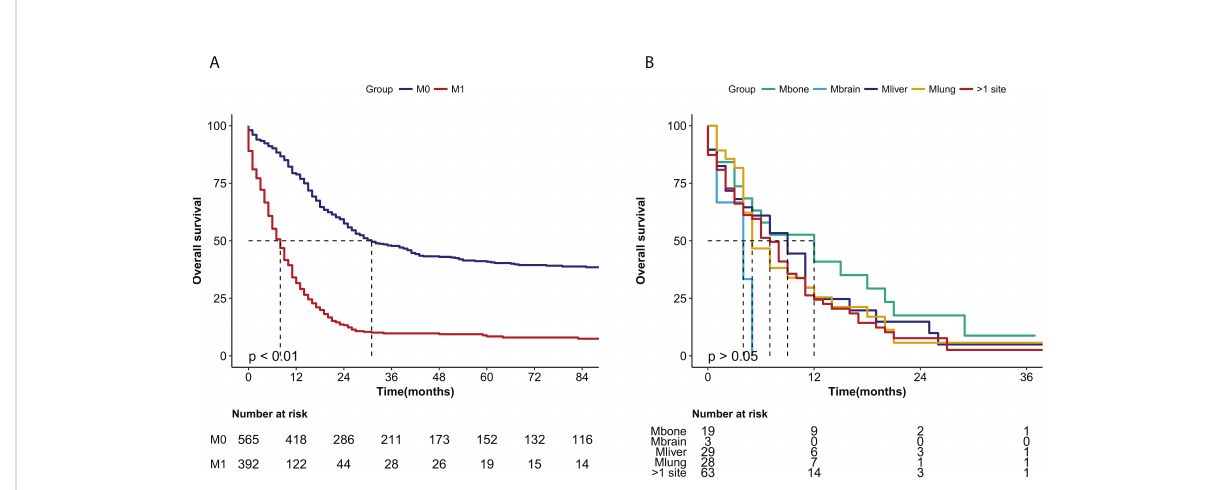
FIGURE 2 Kaplan-Meier curves of the overall survival in NECC cancer strati fi ed by (A) metastasis (M0: no metastasis, M1 metastasis) ( P < 0.0001) and (B) different sites of metastasis (M bone, M brain, M liver, M lung, M >1 site) ( P >